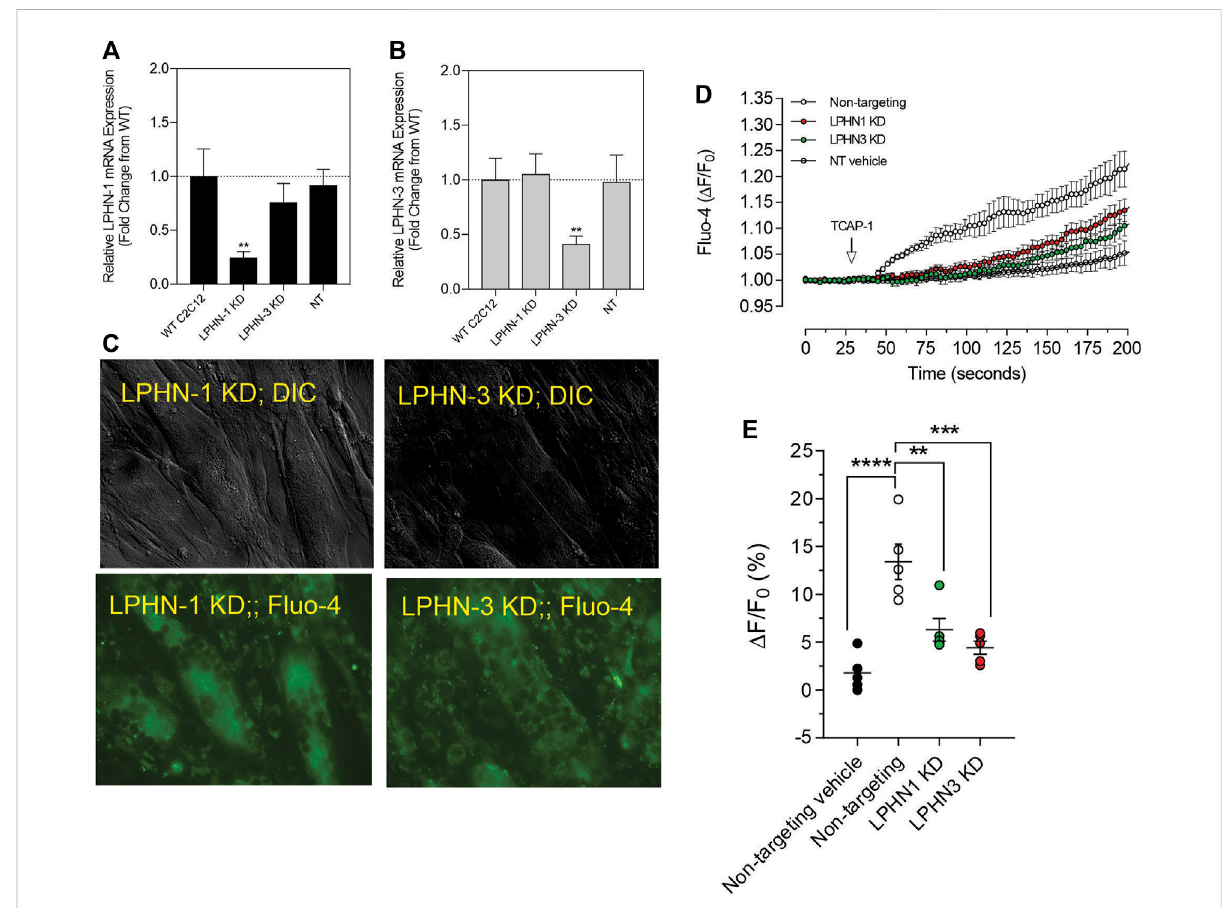
FIGURE 10 siRNAknockdownofLPHN-1and-3inC2C12cells. (A) .CellstransfectedwiththeLPHN-1-targettingsiRNAsshowedasigni fi cantreduction( p < 0.01) inLPHN-1 mRNA expression. (B) . Cellstransfected withthe LPHN-3 targeting mRNA signi fi cantly( p < 0.01)reducedLPHN-3mRNA expression. (C) . Cells treated with either siRNAs showed normal morphology. (D) . Changes in Ca 2+ accumulation in cells transfected with either LPHN-1 or -3 siRNA oligonucleotides. (E) . Quanti fi cation of the data shown in “ D ” at 200